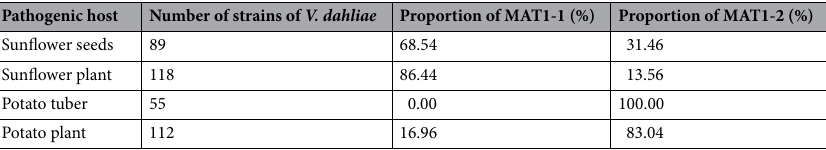
Table 3). Race type identification of V. dahliae isolated from both sunflower and potato were molecular identified as race 2 using race specific primers. Pathogenicity comparison on both mating types isolates. The 20 randomly selected isolates of dif- ferent mating types, MAT1-1 and MAT1-2, previously mentioned were subjected for pathogenicity test on their respective host from which they were isolated initially. After 25 dpi, the disease index of the different mating type isolates obtained from the same host varied (Fig. 3). However, the average disease index of the MAT1-1 potato isolates was 17.29, while that of sunflower was 57.71. For the MAT1-2 isolates, the average disease index of both tested mating type isolates on their respective recovered hosts was recorded as 26.79 for potato and 52.59 for sunflower. This development shows the sunflower isolates were more virulent than the potato isolates, regardless of which mating type was being used for inoculation (Fig. 3).